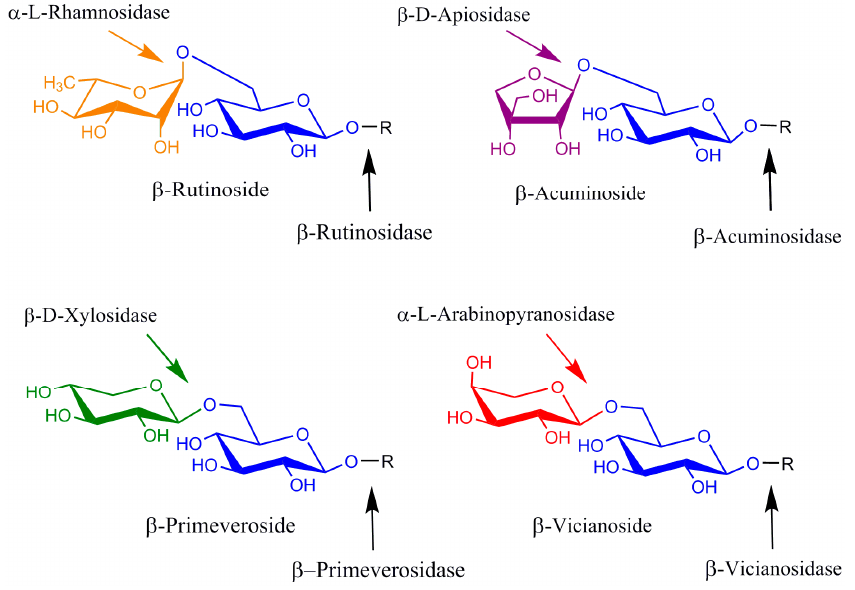
Figure 1. Diglycosidases and exoglycosidases: substrates and cleavage sites.